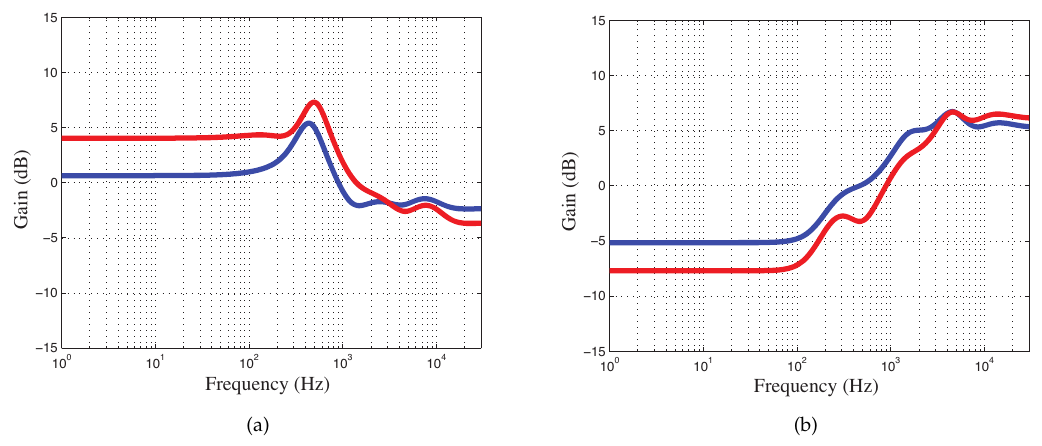
Figure 7. The reconstructed equaliser curves for the centroid of the warm and bright descriptors for both the high-dimensional (red) and low-dimensional (blue) datasets. ( a ) Reconstructed warm equaliser curve; ( b ) Reconstructed bright equaliser